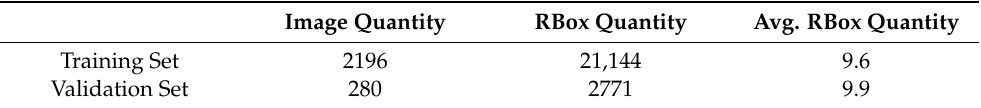
Table 1. Description of the training set and validation set: RBox is short of rotated object boxes and Avg. RBox quantity represents the average number of rotated object boxes of each